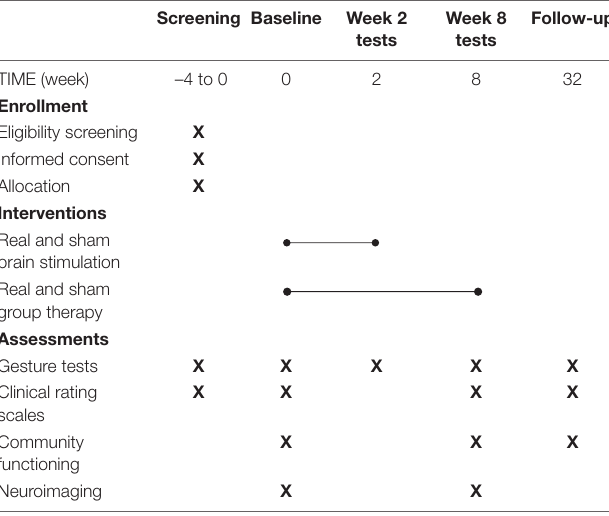
TABLE 3 | Time-points of